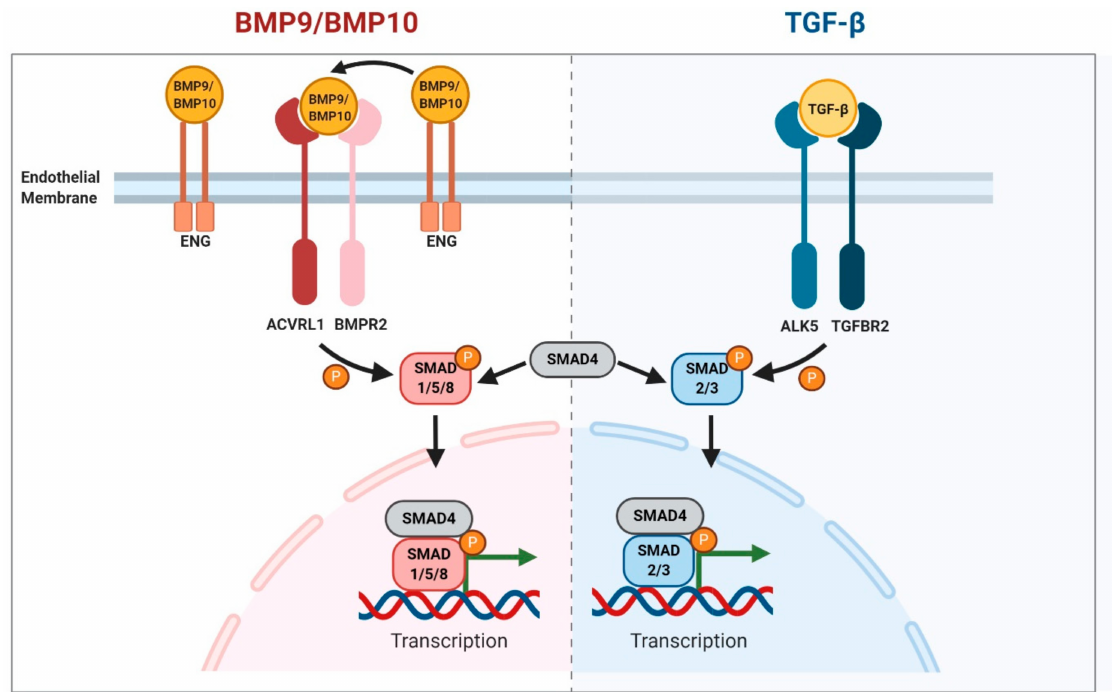
Figure 1. Schematic summary of BMP9/10 and TGF β 1 signalling pathways in endothelial cells. Figure created with BioRender